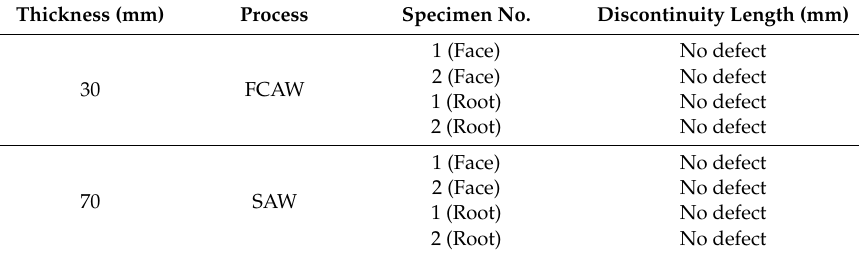
Table 7. Guided bend test results of the welded butt